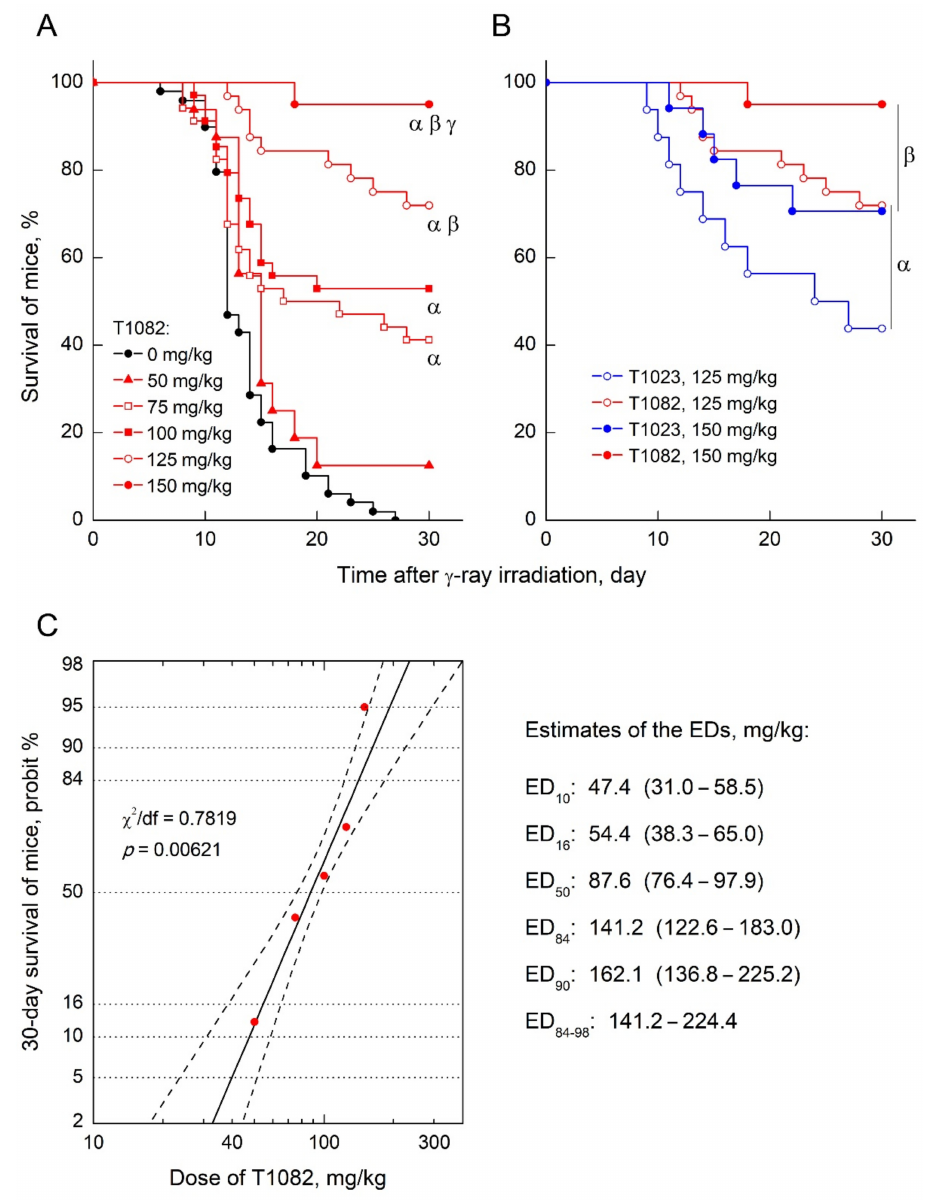
Figure 4. The effect of compounds T1023 and T1082 (single, i.g., 30 min before irradiation) on the survival of F 1 (CBA × C 57 BL 6j ) mice after 9 Gy γ -ray TBI. ( A ) Effects of compound T1082 at doses of 50–150 mg/kg. Data represent the combined results of two independent experiments ( n = 20–34 per group). Survival was plotted using the Kaplan–Meier method. α , significantly different vs. irradiated control mice ( p = 0.01222, p = 0.00943, p = 0.00007, and p < 0.00001, respectively). β , significantly different from the group treated at a dose of 75 mg/kg ( p = 0.01370 and p = 0.00031). γ , significantly different from the group treated at a dose of 125 mg/kg ( p = 0.00542). ( B ) Effects of compounds T1023 and T1082 at doses 125 and 150 mg/kg. Data represent the combined results of two independent experiments ( n = 15–34 per group). Survival was plotted using the Kaplan–Meier method. α , significant difference in effects at a dose 125 mg/kg ( p = 0.01683). β , significant difference in effects at a dose 150 mg/kg ( p = 0.02685). ( C ) Dose dependence of the radioprotective efficacy of compound T1082 on the 30-day survival of mice (probit analysis). Graphic points represent experimental indicators of 30-day survival of mice (from (A)). Solid line, mean expected effective doses of compound T1082 (probit-logarithmic regression; p shows the significance of regression). Dashed lines, 95% confidence interval of expected effective doses. On the right are estimates of ED values with different radioprotective efficiencies (in brackets—95% confidence interval for